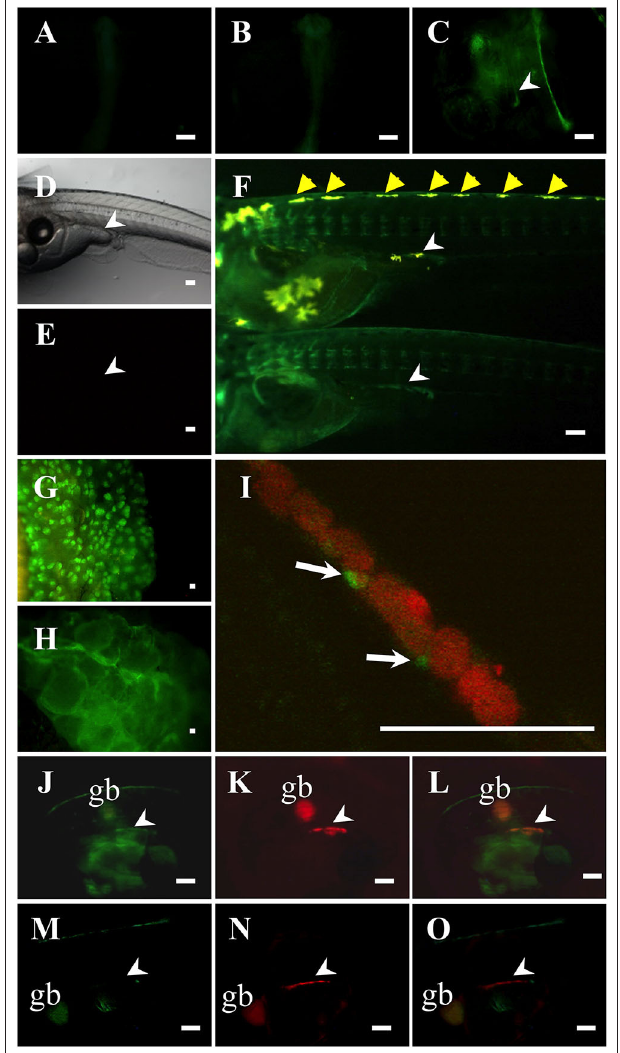
FIGURE 2 | Characterization of mis-GFP transgenic medaka. GFP expression in mis (–3.1-kb)-GFP transgenic medaka at 1-dpf (A) , 2-dpf (B) , and 4-dpf (C) . Non-transgenic medaka at 9-dpf in bright field (D) and in dark field (E) . GFP expression in mis ( − 3.1-kb)-GFP transgenic medaka at 9-dpf ( F : upper, XY; lower, XX; at hatching), testis (G) , and ovary (H) . (I–L) mis (–3.1-kb)-GFP/olvas-DsRed double transgenic medaka at 9-dpf. The expression of GFP (J) and DsRed (K) , and a merged image (I,L) are shown. (M–O) mis ( − 0.8-kb)-GFP/olvas-DsRed double transgenic medaka at 9-dpf. The expression of GFP (M) and DsRed (N) , and a merged image (O) are shown. White arrow: GFP-positive cell; White arrowhead: gonadal region; yellow arrowhead: leucophore; gb, gallbladder. Scale bar: 100 µ